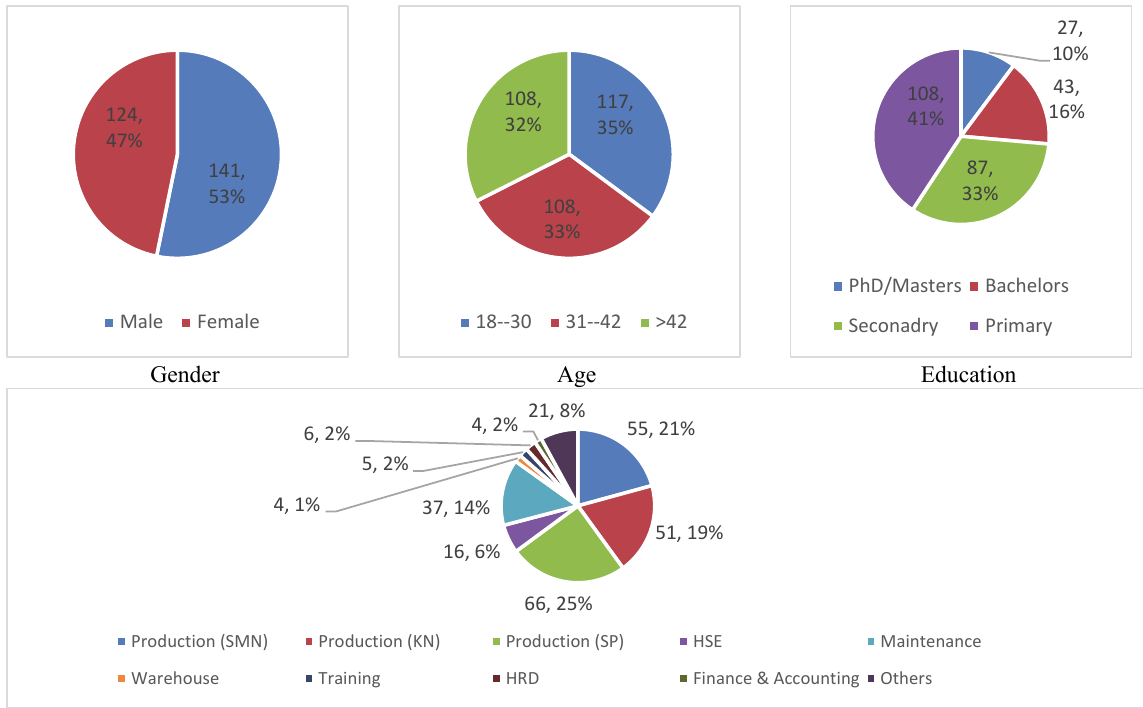
Fig. 2. Demographic profile of the respondents